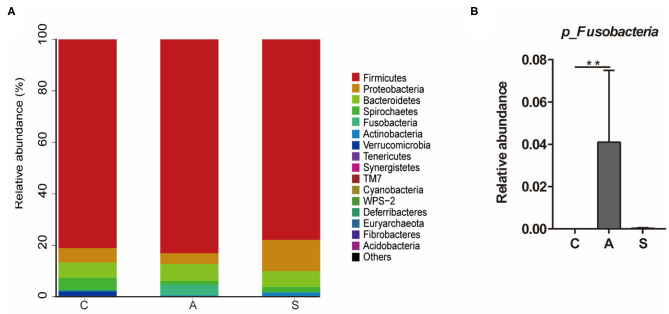
Effect of maternal synbiotic supplementation on the colonic microbial community structure in suckling Bama mini-piglets. Colonic microbiota distributed at the phylum level (A) and all phyla were listed. A comparison of relative abundances at the phylum level (B) was analyzed by Metastats analysis, and the discrepancy of the top 10 colonic microbiota was listed. Phyla with proportion < 0.001 were grouped in others. **P < 0.01. n = 8 per group.